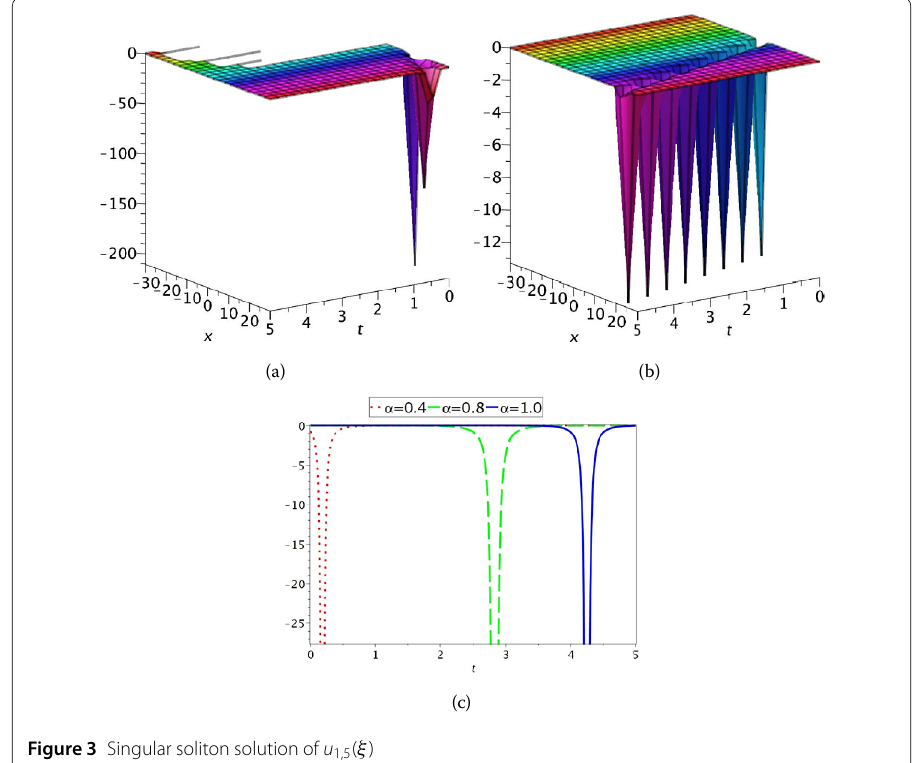
Figure 3 Singular soliton solution of u 1,5 ( ξ )